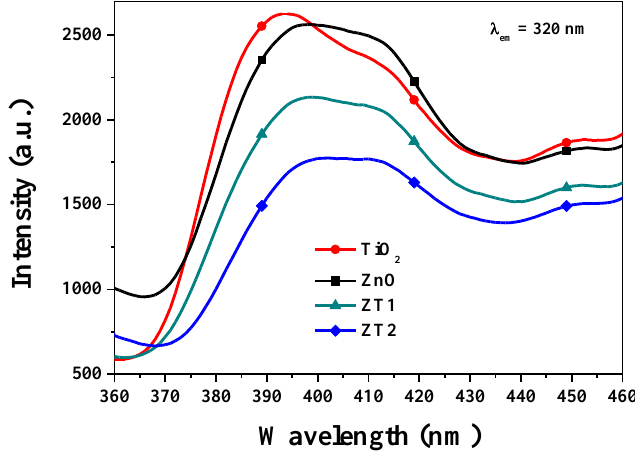
Figure 5. PL spectra of the prepared films (the emission wavelength is 320 nm).